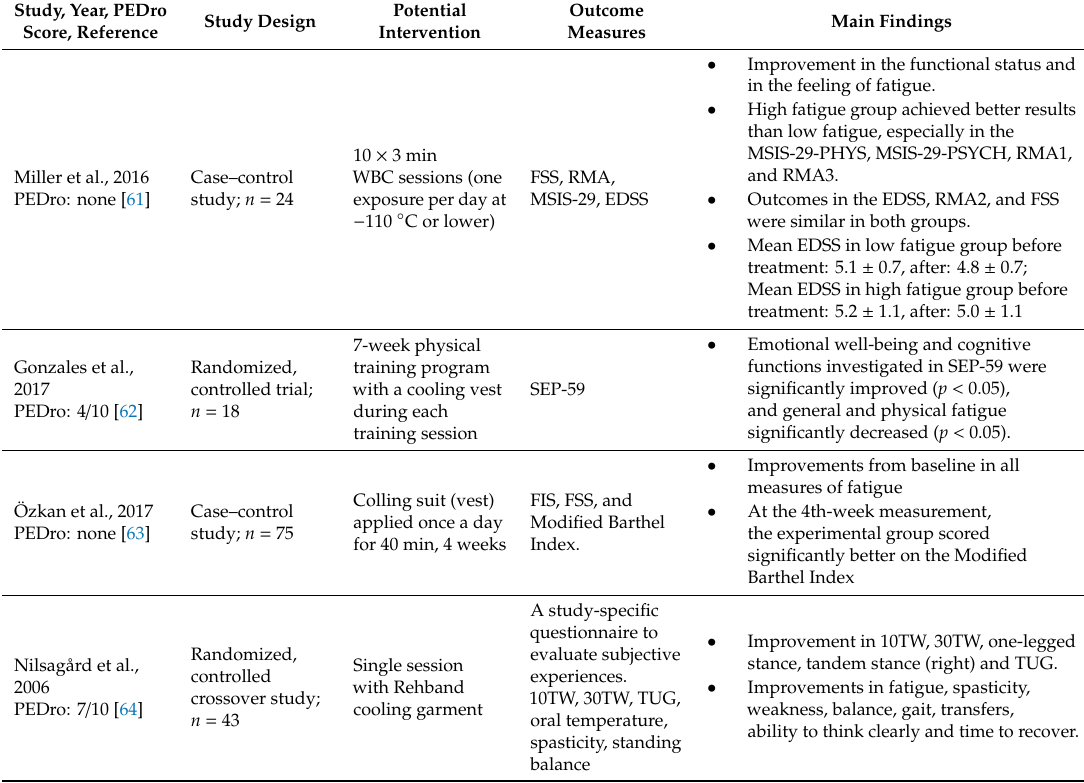
Table 3. Clinical studies of cold therapies in patients with MS-related